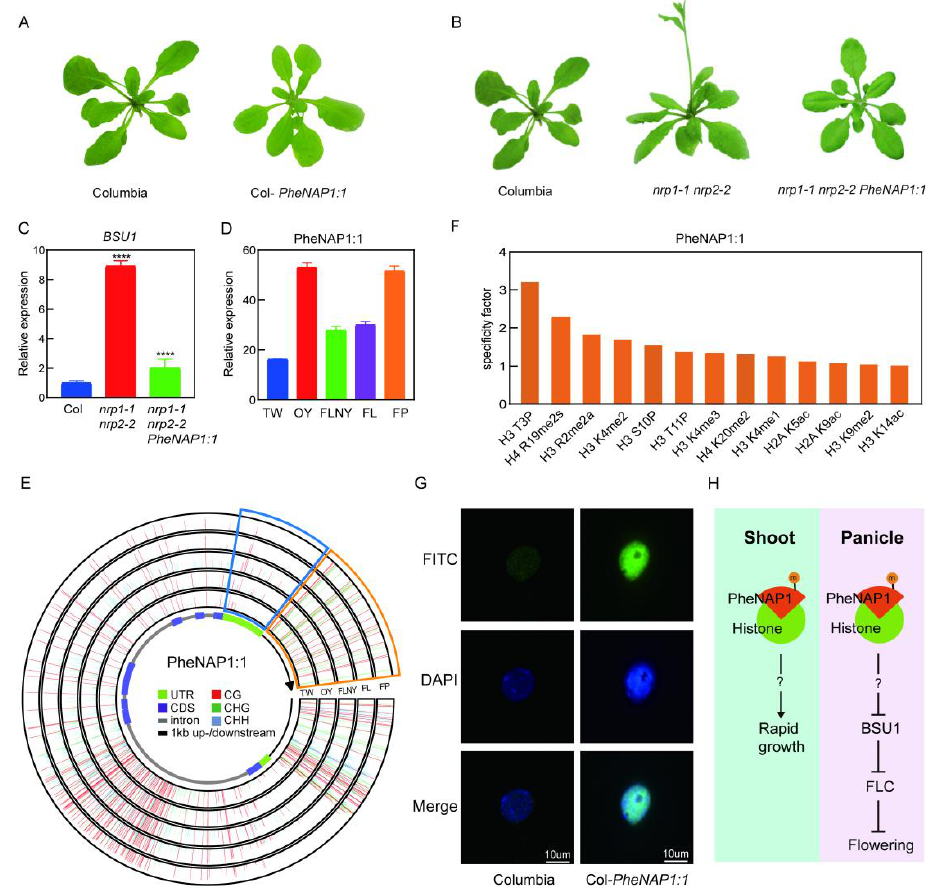
Figure 4. Functional analysis of PheNAP1:1. ( A ) The phenotype of Arabidopsis thaliana (Ecotype Columbia) and transgenic plant Col- PheNAP1:1 grown under long-day conditions. ( B ) Morphological phenotype of Columbia, nrp1-1 nrp2-2 , and transgenic plant nrp1-1 nrp2-2 PheNAP1:1 grown under long-day conditions. ( C ) Relative expression of BSU1 in Columbia, nrp1-1 nrp2-2 , and nrp1-1 nrp2-2 PheNAP1:1 measured by RT-qPCR. Error bars represents standard deviation. ****: p < 0.0001. UBQ10 was used as an internal control. ( D ) Expression analysis of PheNAP1:1 in different tissues according to transcriptome data. TW: leaves of 3-week-old seedlings, OY: leaves of 1-year-old plants, FLNY: leaves of plants that will flower in the next year, FL: leaves of flowering plants, FP: flower florets. ( E ) Comparison of DNA methylation profile of PheNAP1:1 in TW, OY, FLNY, FL, and FP. Wiggle plot showing methylation level in gene body and up-/downstream region of the PheNAP1:1 locus. ( F ) Histone modification analysis of PhNAP1:1. ( G ) Immunofluorescence of PheNAP1:1. FITC: fluorescein isothiocyanate. ( H ) The assumed pathway PheNAP1:1 involved. M: DNA